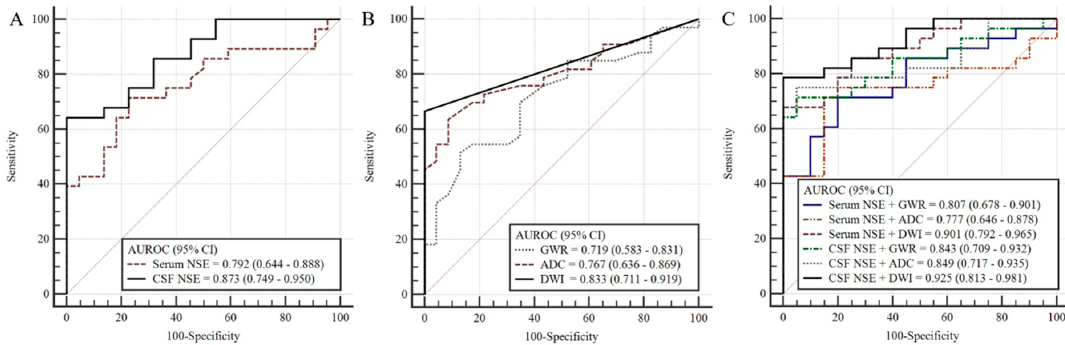
Figure 3. Comparison of receiver operating characteristic curves of ( A ) CSF NSE and serum NSE levels; ( B ) HSI in DWI, voxels of ADC, and GWR in CT, and; ( C ) combinations of NSE levels and brain images. AUROC, area under the receiver operating characteristic curve; CI, confidence interval; HIS: high signal intensity; GWR, grey-to-white matter Table 3. Prognostic performances of levels of serum and CSF NSE, DWI, ADC, and GWR for predicting three-month poor neurological outcome.